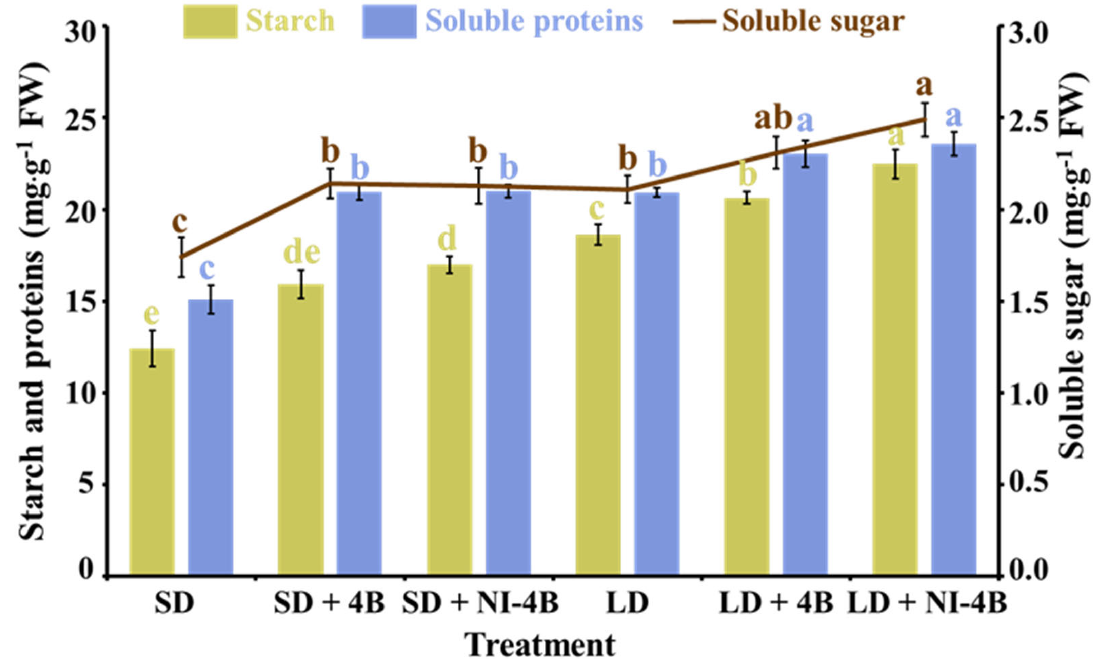
Figure 7. The effects of the supplementary and night-interrupting 10 µ mol · m − 2 · s − 1 PPFD B light on the accumulation of carbohydrates and soluble proteins in kalanchoe ( Kalanchoe blossfeldiana ‘Rudak’), after 60 days of exposure to the photoperiodic light treatments. Vertical bars indicate the means ± standard error ( n = 6). Different lowercase letters indicate significant separation within treatments by the Duncan’s multiple range test at p ≤ 0.05. (See Figure 2 for details on the photoperiodic treatments with B light).